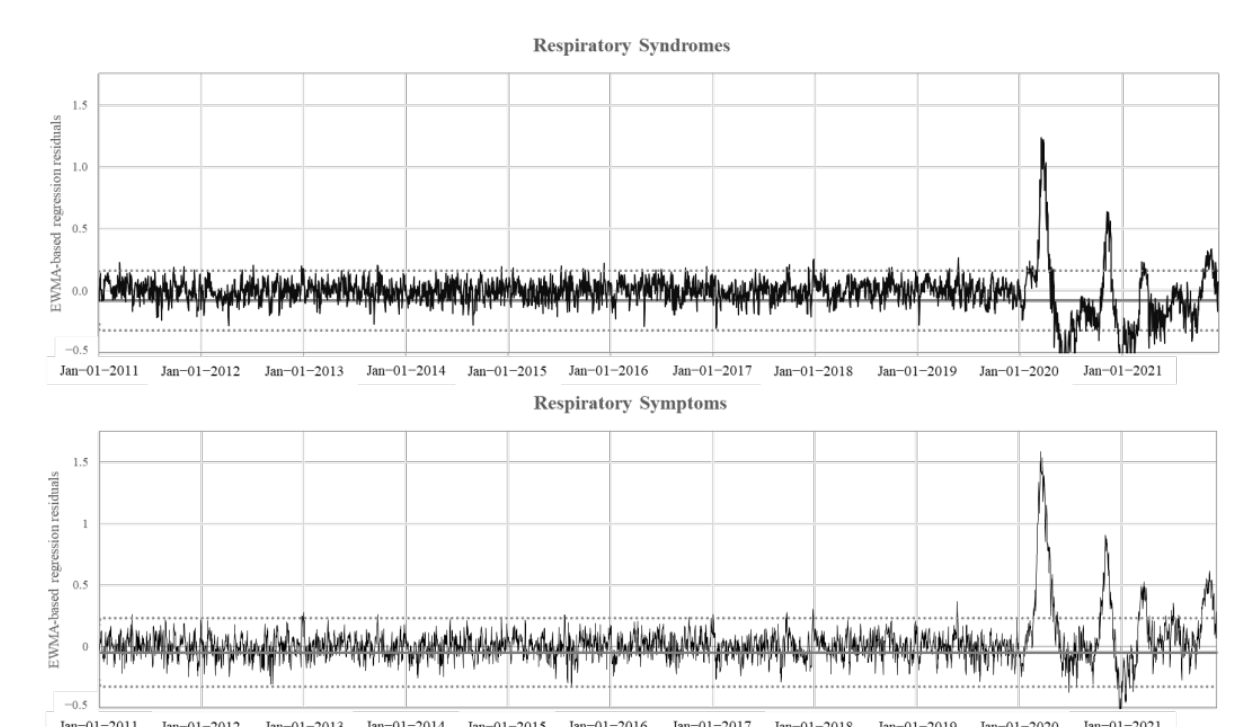
Figure 2. Model-based residual of the daily trends in the number of ED visits with either respiratory syndrome read codes or recognized through respiratory symptoms recorded in the free text of medical records, between 1 January 2011 and 9 December 2021. Mean value of the entire series and the upper/lower control limits used to prepare the exponentially weighted moving average (EWMA) control chart are shown.